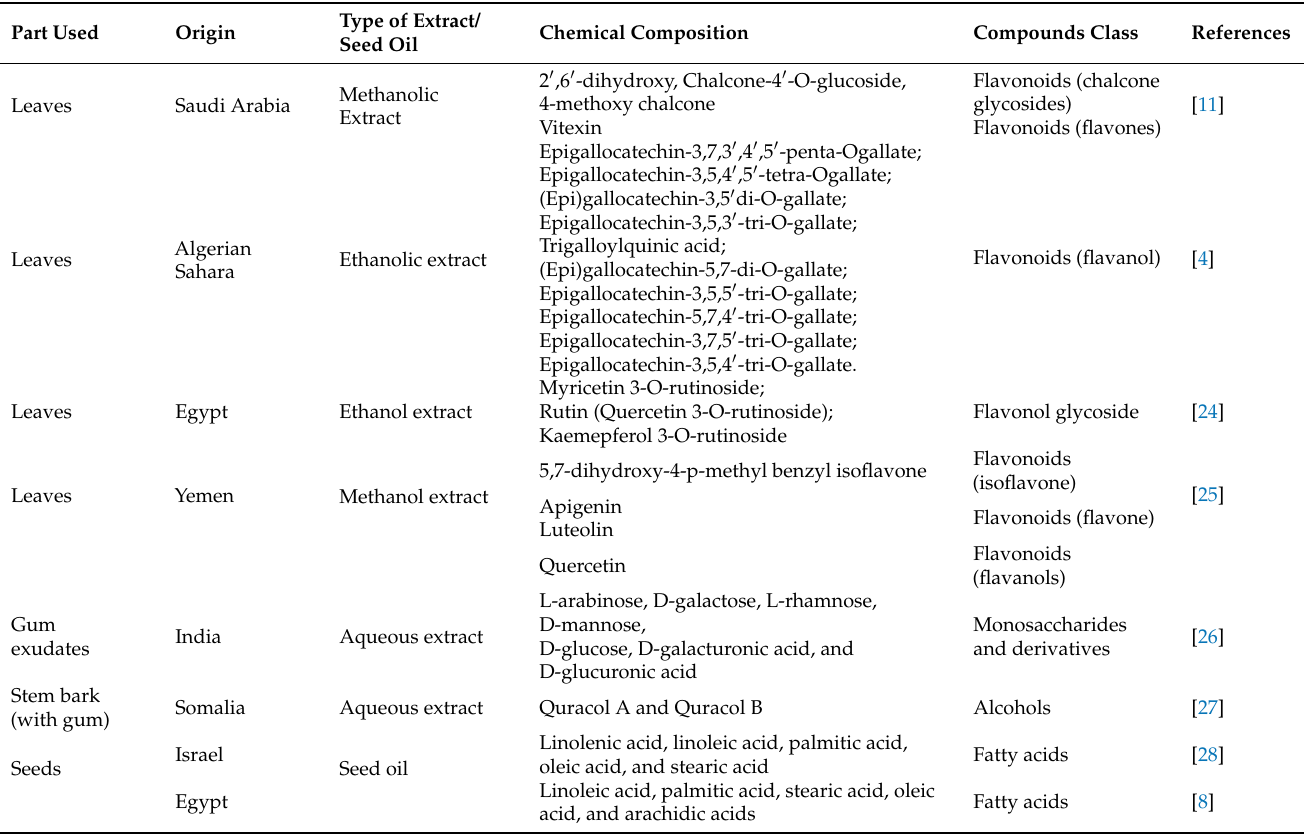
Table 2. Chemical composition of different V. tortilis plant parts